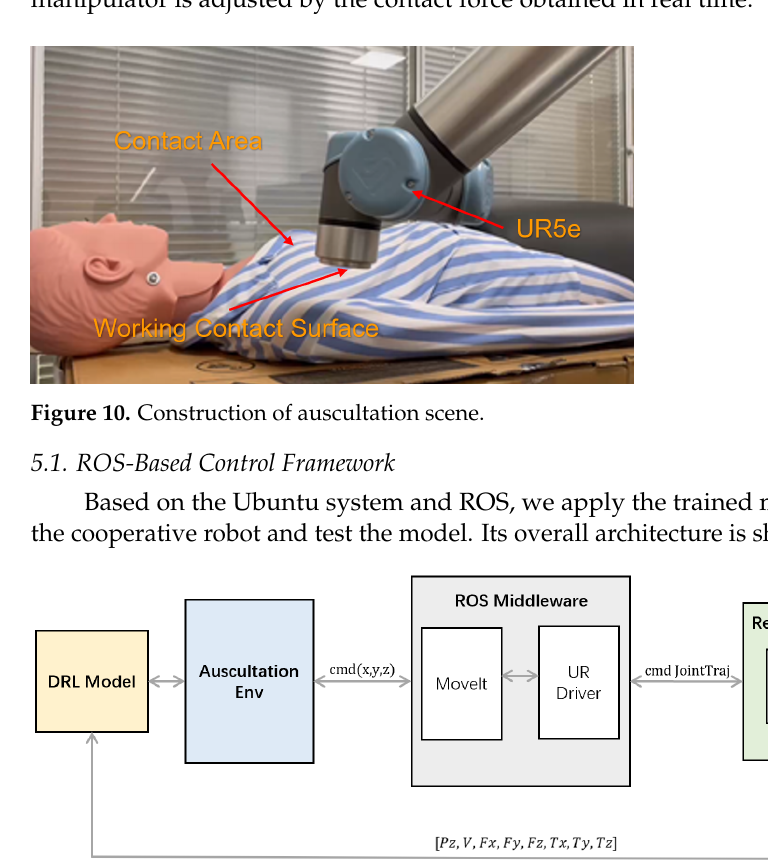
Figure 11. Control